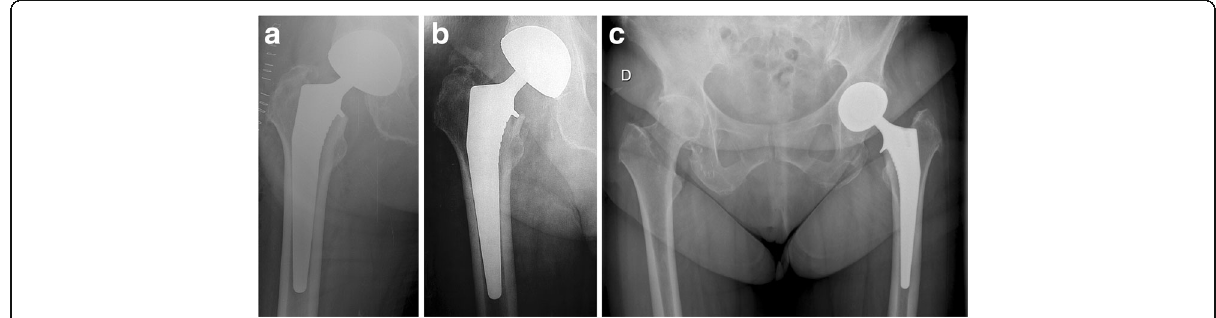
Fig. 1 a Immediate post-operative and b 2 months post-operative X-rays of a right hip after total hip arthroplasty with insufficient collar size, showing slight subsidence with signs of calcar fracture. c Post-operative X-ray of a left hip illustrating an oversized collar, which may cause impingement on surrounding soft